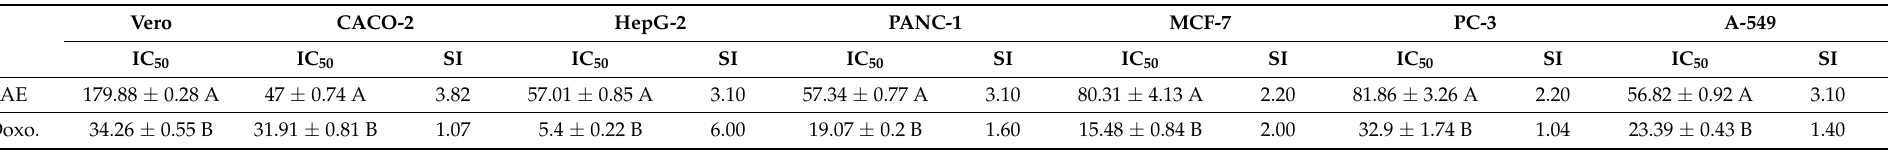
Table 2. Cytotoxicity of Annona extract against Vero, Caco-2, HepG-2, Panc-1, Mcf-7, Pc-3, and A-549 cell lines in parameters of IC 50 values (M ± SE) and